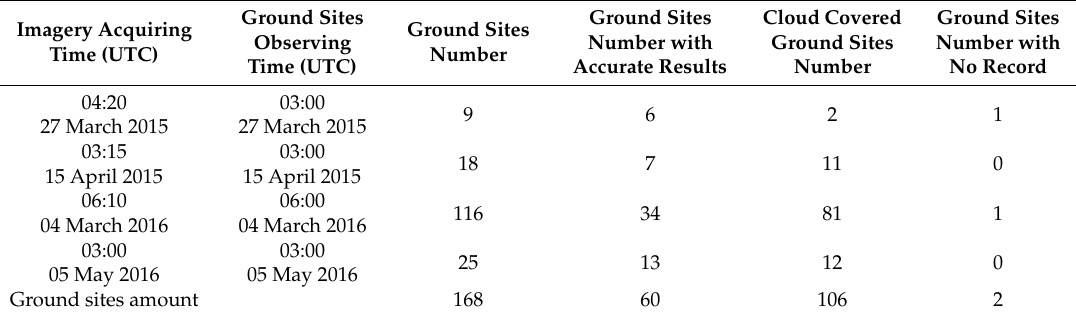
Table 6. Validation of the monitoring results with the MICAPS